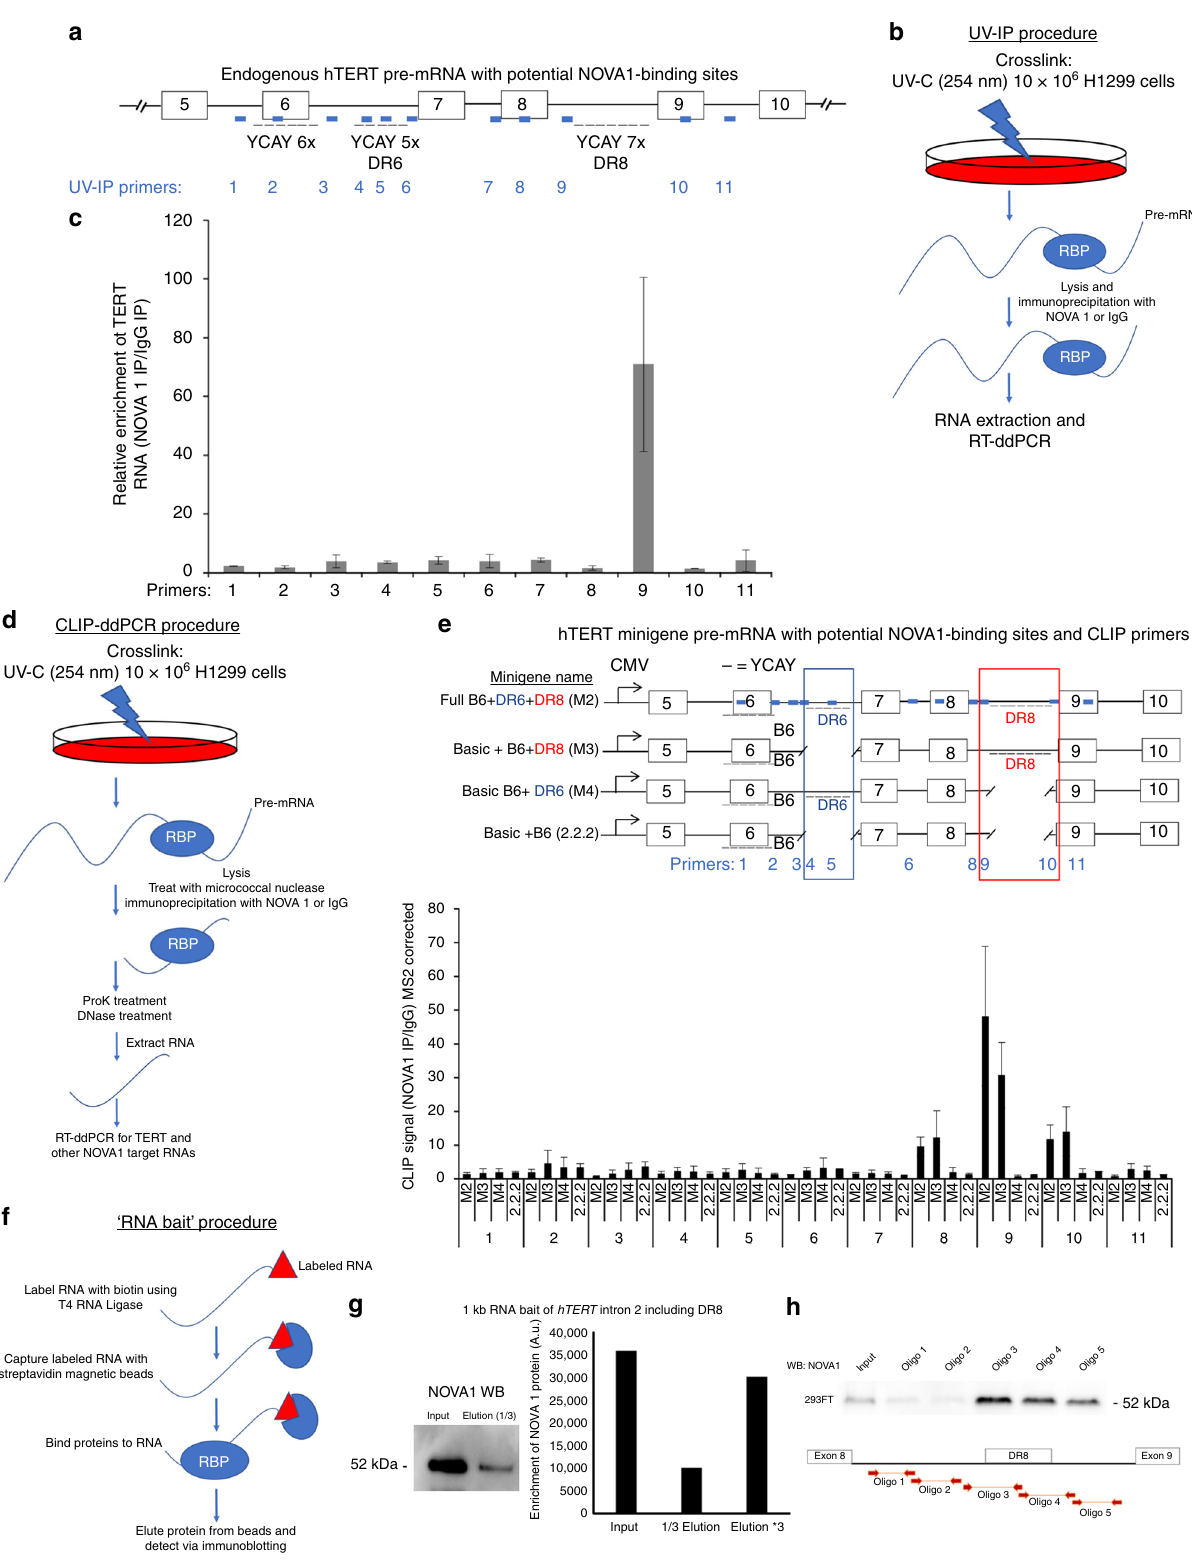
1 kb RNA bait of hTERT intron 2 including DR8